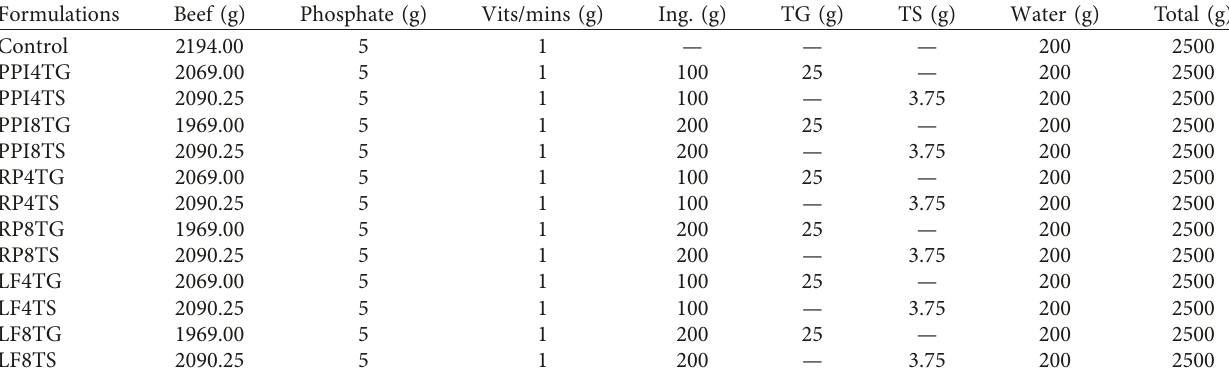
Table 1: Formulation of restructured beef